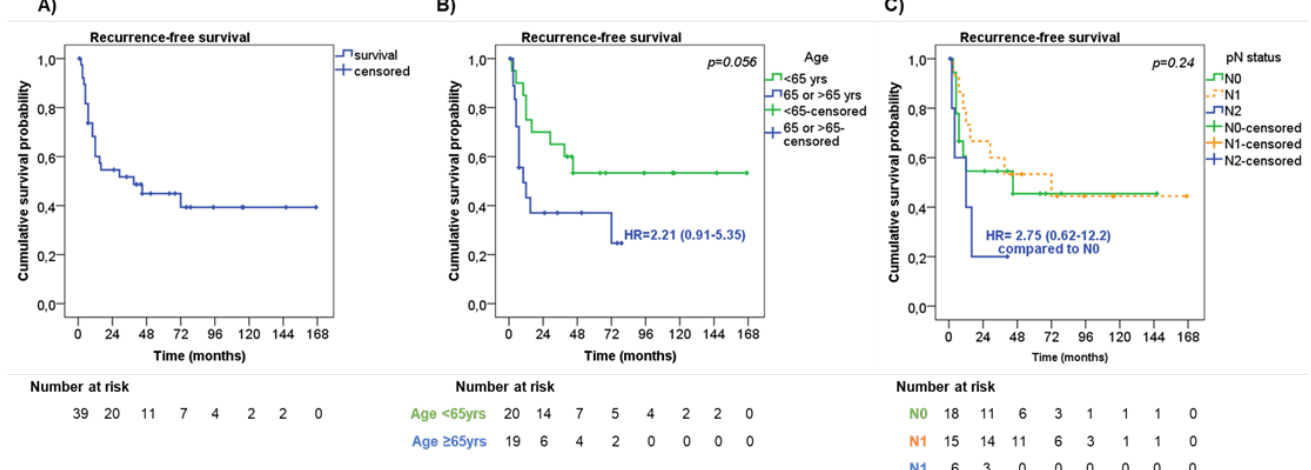
Figure 2. Recurrence-free survival. ( A ) Recurrence-free survival (RFS) in the entire cohort of patients. RFS according to age ( B ) and lymph node metastasis — pN status ( C ).